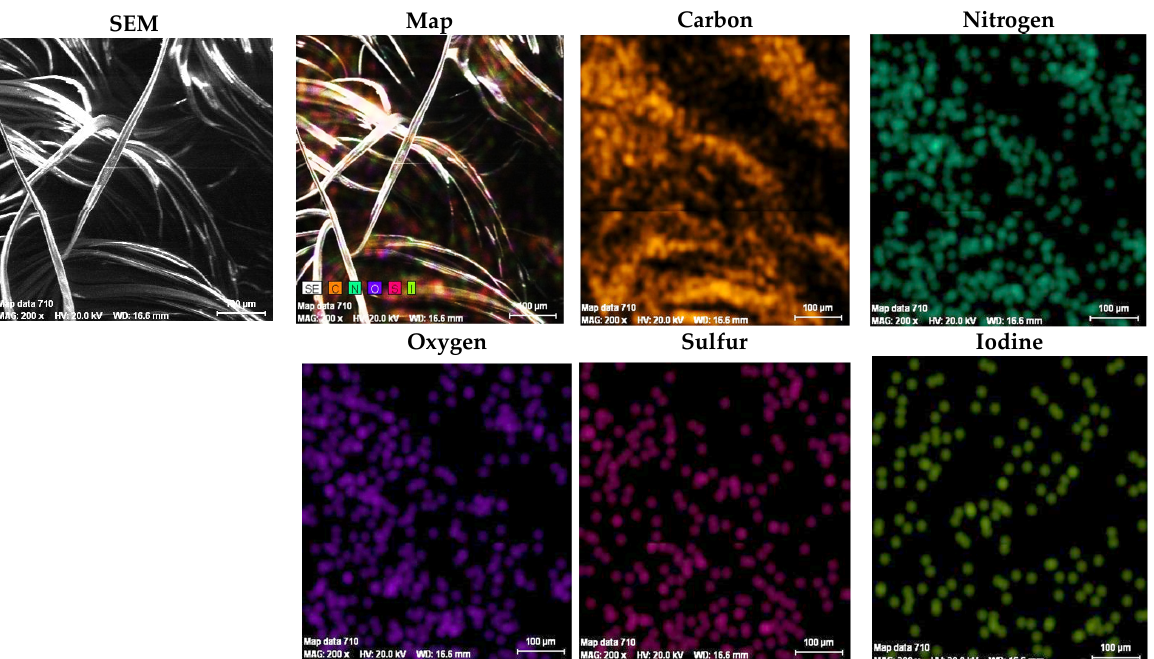
Figure 11. SEM image and elements mapping of untreated Dralon L fibers.